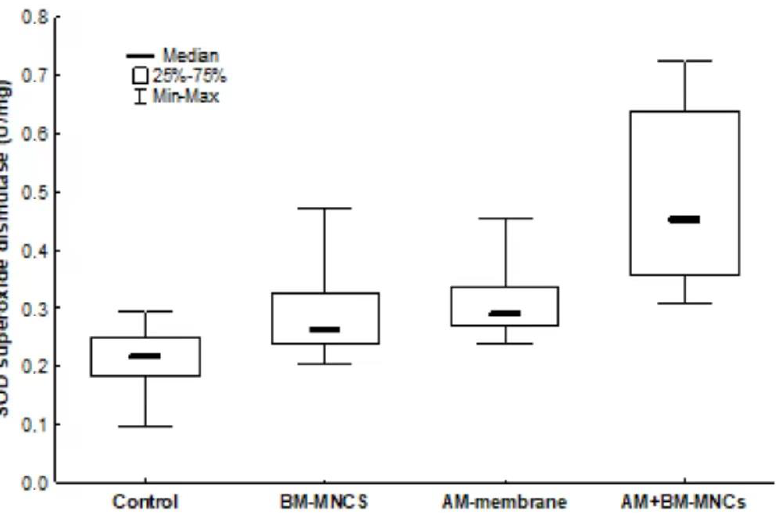
Figure 9. Effect of AM and BMSCs on SOD superoxide dismutase activity. Results are expressed as mean [interquartile range] ± SEM (N = 10). p < 0.05 denoted statistical significance in comparison to the control group. BMSCs: bone marrow mononuclear stem cells; AM : acellular human amniotic